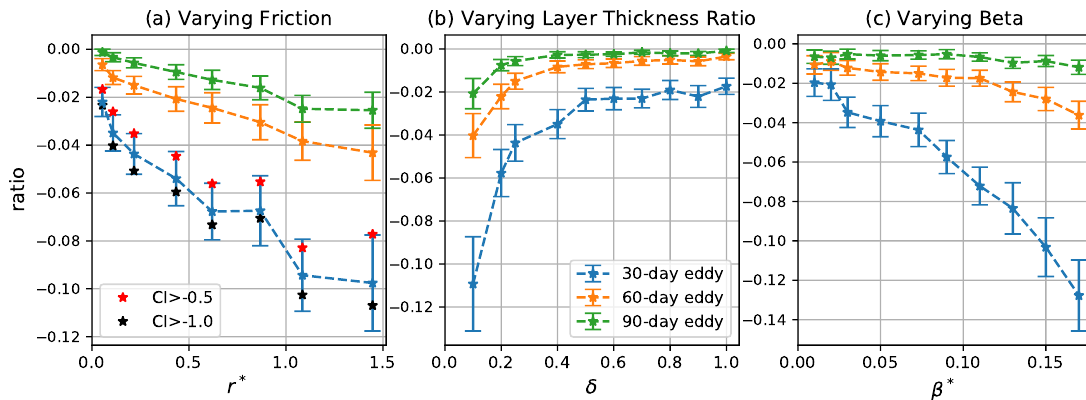
Figure 12. Ratio of meridional PV transport due to trapping of coherent eddies to total PV transport as a function of ( a ) r ∗ , ( b ) δ , and ( c ) β ∗ . Blue, orange, and green curves correspond to the mean of the ratio for 30-, 60-, and 90-day eddies, respectively. Error bars give two times the standard error of the mean over 100 time intervals. Red and black stars in the left panel indicate the mean for 30-day eddies detected by varying the CI threshold to − 0.5 and − 1.0,